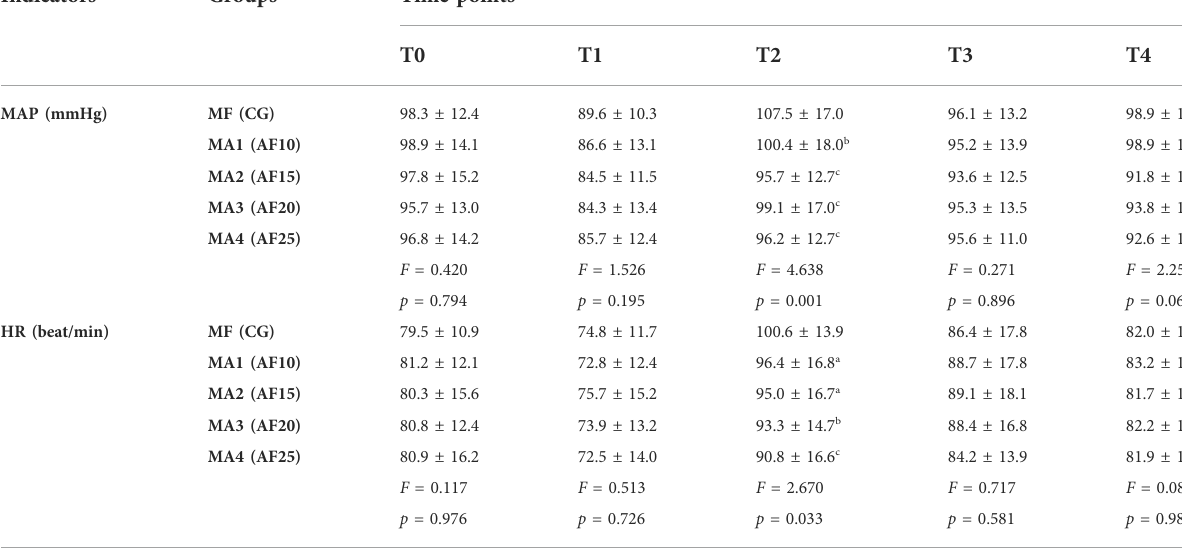
TABLE 2 Comparison of the fi ve groups with regard to vital signs(MAP and HR) recorded at different time point during the procedure (n = 50).